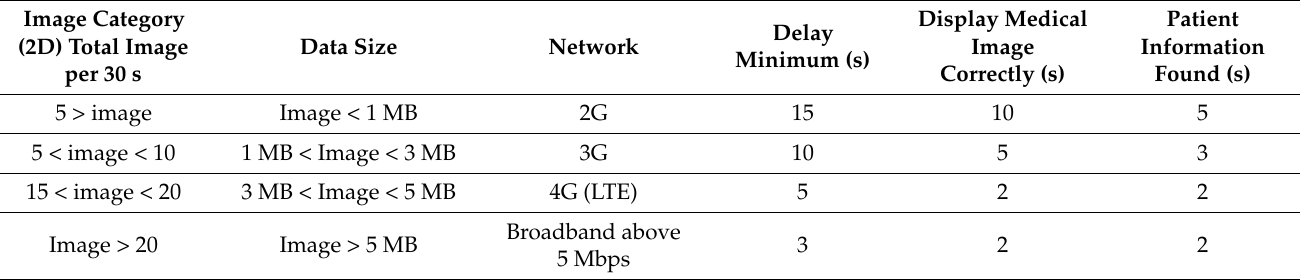
Table 2. Image display in IoT server by